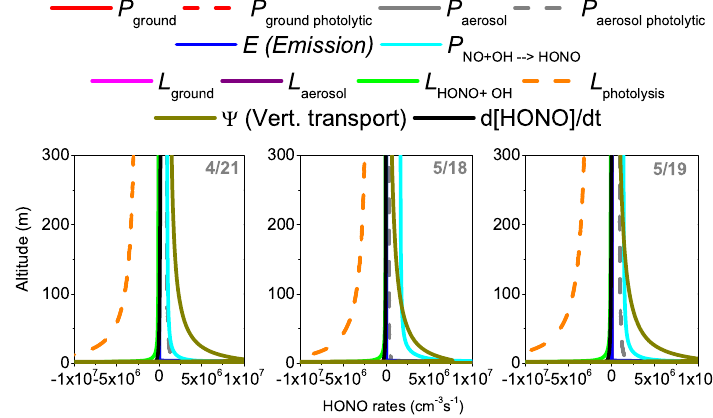
Fig. 9. Vertical profiles of the modeled HONO formation and loss pathways in the lowest 300m at noon on 21 April, 18 May, and 19 May. The vertical transport term describes how much HONO is added or removed by vertical transport at each altitude.